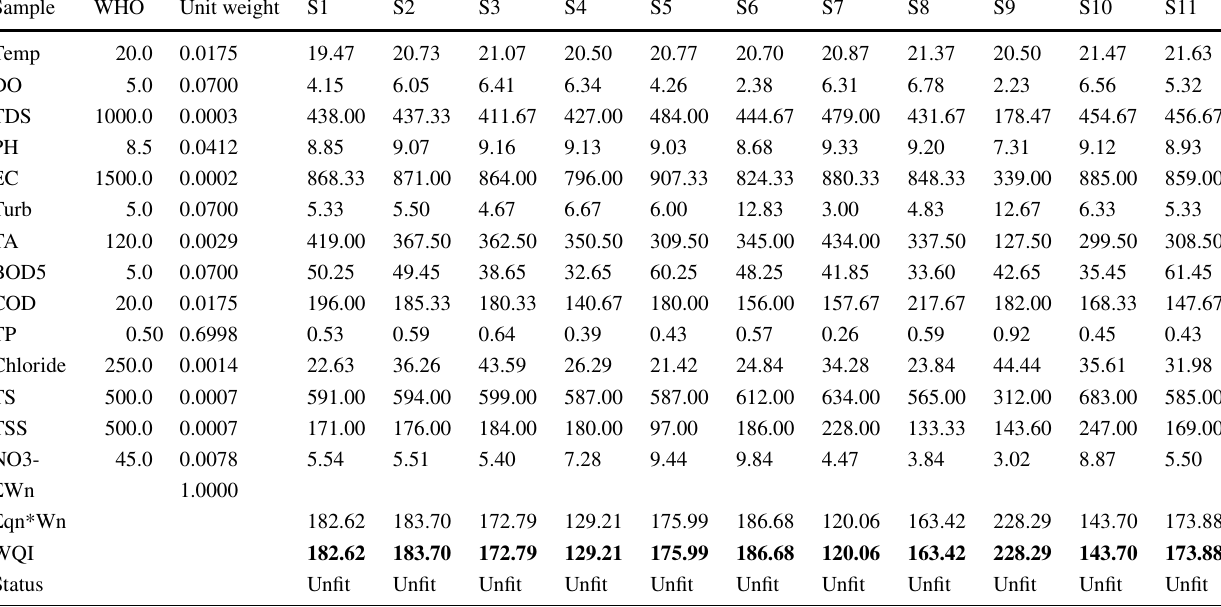
Table 3 Weighted arithmetic water quality index results